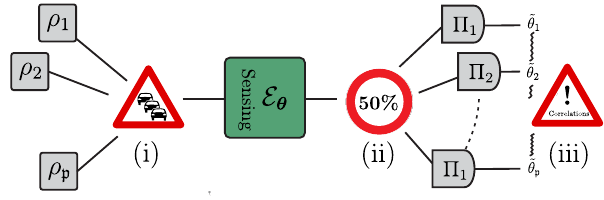
FIG. 1. Three potential sources of incompatibility in multi- parameter quantum metrology. (i) Different input probe states may be optimal to estimate different parameters. This may in the worst-case lead to a p -fold increase in the resources consumed, compared with the best case where a single-probe state is optimal for estimating all parameters. (ii) Different incompatible mea- surements may be optimal for extracting information about different parameters. In generic noisy metrological models, this will require at most double the required resources in the asymptotic regime, where many probes may be used. (iii) If the chosen parametrization is not “ natural ” for the problem at hand, the resulting estimators will manifest correlations, and the imperfect knowledge of some parameters will have an impact on the effective estimation uncertainty of the remaining